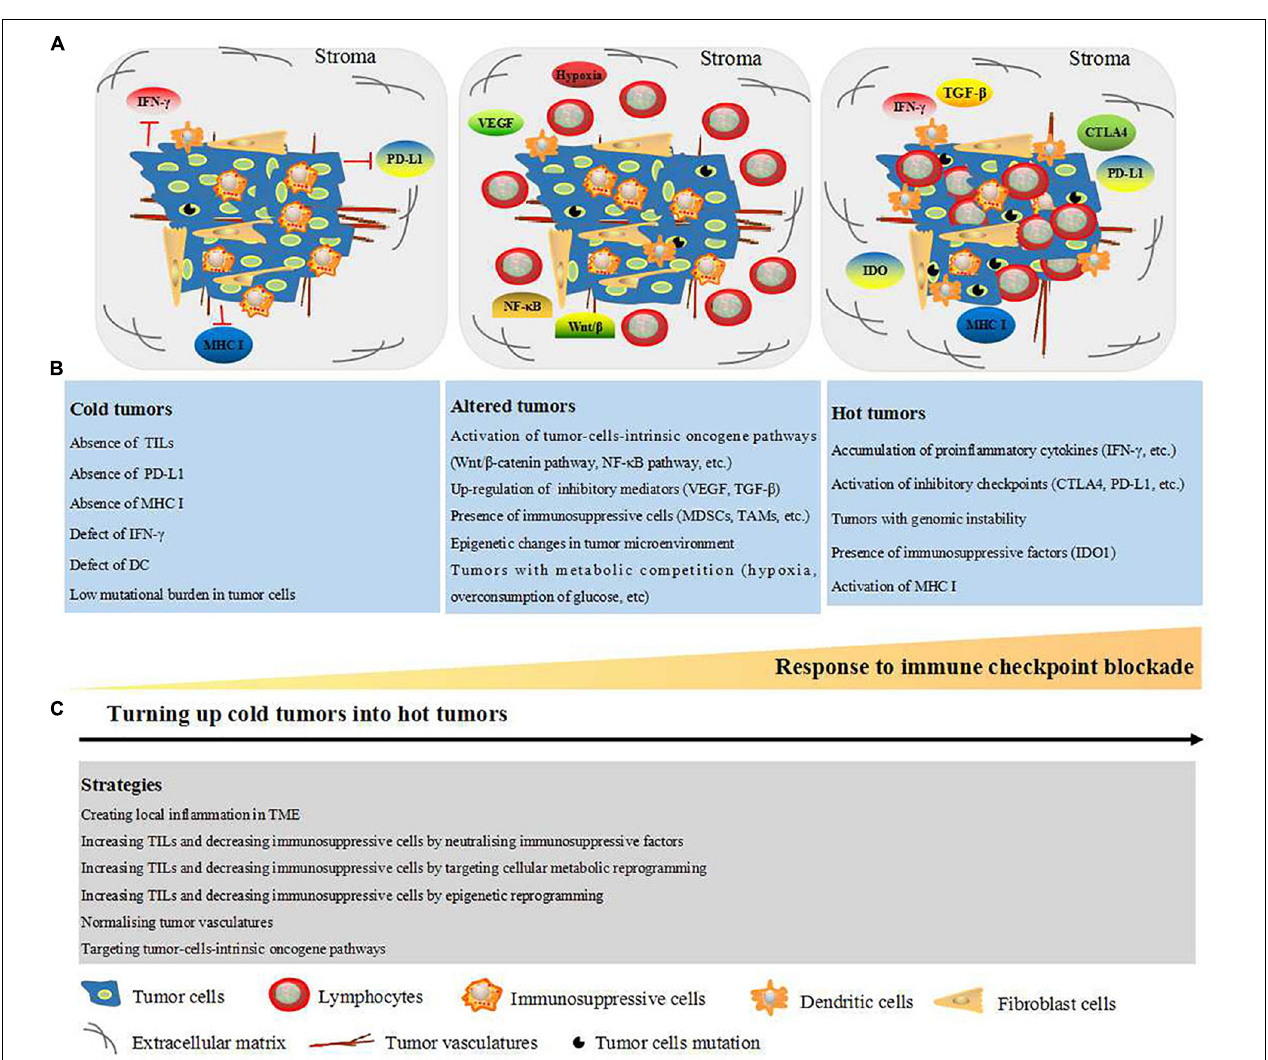
FIGURE 1 | Schematic representation of TME-dependent hot, altered, and cold tumors and strategies to turn up cold tumors into hot tumors. (A) TME consist of cellular components: tumor cells, fibroblast cells, DC, immunosuppressive cells [MDSCs, regulatory T cells (TAMs)], and lymphocyte (mainly T cell). Non-cellular components: tumor vasculature, ECM, oxygen, and metabolites. (B) Based on the TILs within the tumor site and response to immune checkpoint blockade, the tumors are classified into cold, altered, and cold tumors. Cold tumors are non-effective to immune checkpoint blockade and characterized with absence of TILs, PD-L1, MHC I, IFN- γ , and DC, which are all essential for neoantigen presentation. Furthermore, cold tumors are presented as low mutational burden in tumor cells. Altered tumors are represented with stromal T cells as well as the factors which prevent infiltration of T cells into the tumors, such as activation of tumor-cell-intrinsic oncogene pathways, upregulation of soluble inhibitory mediators (VEGF and TGF- β ), and presence of immunosuppressive cells (MDSCs, TAMs, and regulator T cell). Moreover, epigenetic changes and metabolic competition (hypoxia and overconsumption of glucose) in tumor microenvironment are presented in the altered tumors. Hot tumors are represented with high degree of TILs and sensitive to immune checkpoint blockade. Additionally, hot tumors are characterized with accumulation of proinflammatory cytokines (IFN- γ , etc.), inhibitory checkpoints (CTLA-4, PD-L1, etc.), IDO1, MHC I, and genomic instability (high tumors mutation burden). (C) Strategies to turn up cold tumors into hot tumors including creating local inflammation in TME, increasing TILs, and decreasing immunosuppressive cells by neutralizing immunosuppressive factors, targeting cellular metabolic reprogramming, targeting epigenetic reprogramming, targeting tumor-cell-intrinsic oncogene pathways, and normalizing tumor vasculature. CTLA-4, cytotoxic T-lymphocyte-associated antigen 4; DC, dendritic cell; ECM, extracellular matrix; IDO1, indoleamine 2,3-dioxygenase 1; IFN- γ , interferon gamma; TME, tumor microenvironment; MDSCs, myeloid derived suppressor cells; MHC I, major